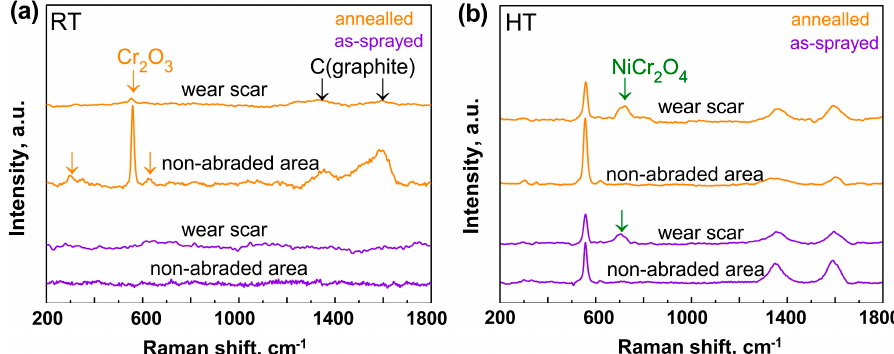
Figure 8. Raman spectra of the wear scar and the non-abraded regions of the as-sprayed and the annealed coatings after wear tests at ( a ) RT and ( b ) 600 °C. The annealed coatings with different holding times show similar features before and after wear tests, therefore only the 192 h-annealed coating is presented here as a representative.